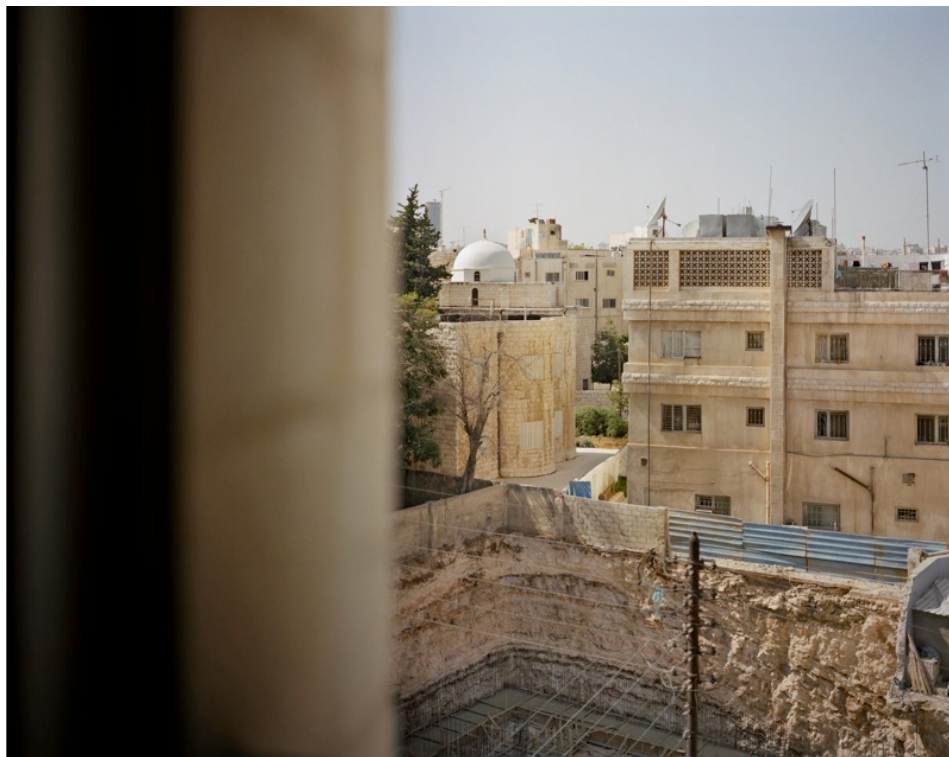
Figure 10 Regina Mamou, Untitled (Site #1) from the series Mapping Collected Memory, 2009–2010. Digital C-print. 40 x 50 in. (101.60 x 127